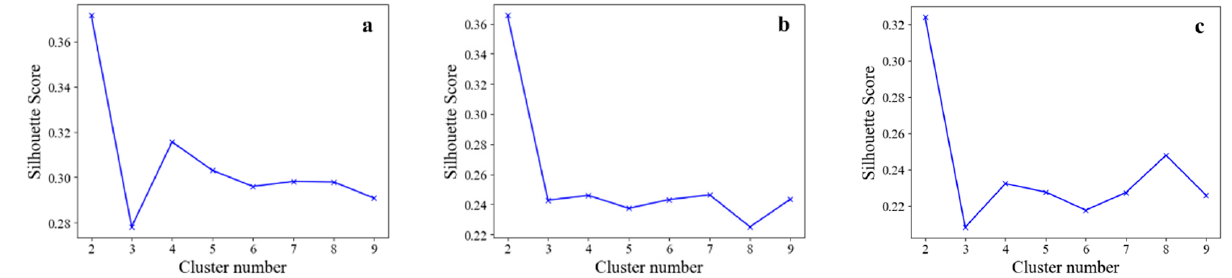
Figure 6. Results of the optimal cluster number selection in Shanxi’s living rooms (( a ). Early heating period; ( b ). mid heating period; ( c ). late heating period).